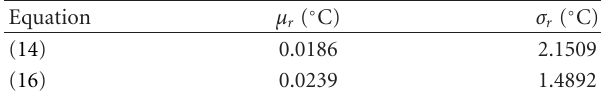
Table 7: Statistics of the residuals. Weekly average